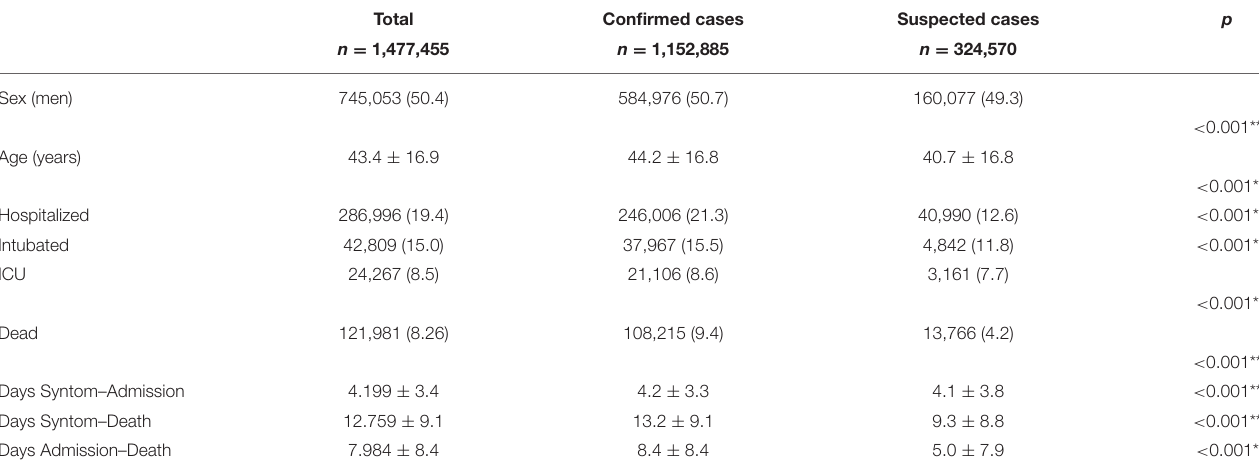
TABLE 1 | General characteristics a